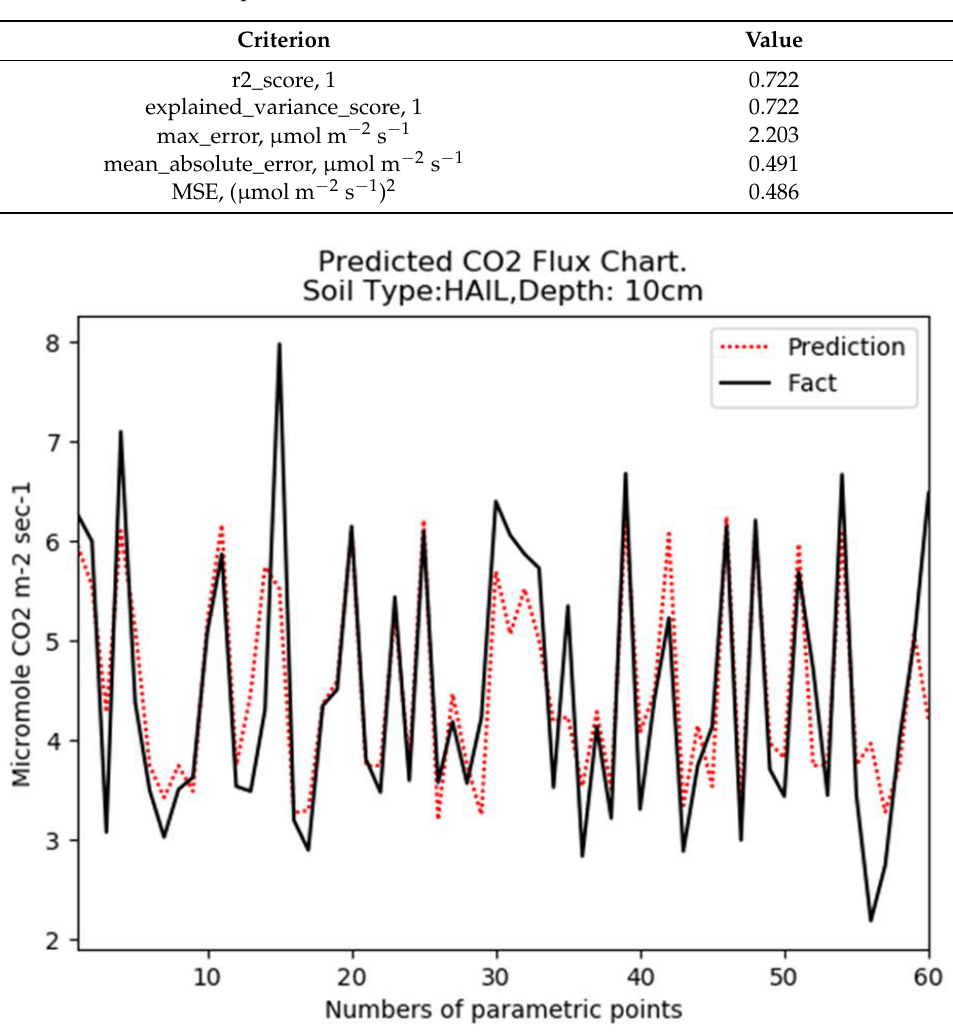
Figure 3. Regression approximation results in experiment 2.